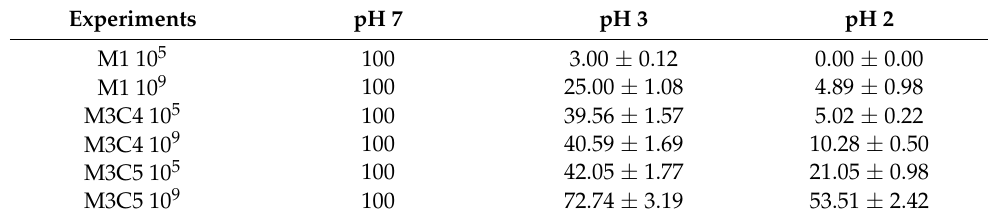
Table 4. The W. confusa resistance rate at lower pH.